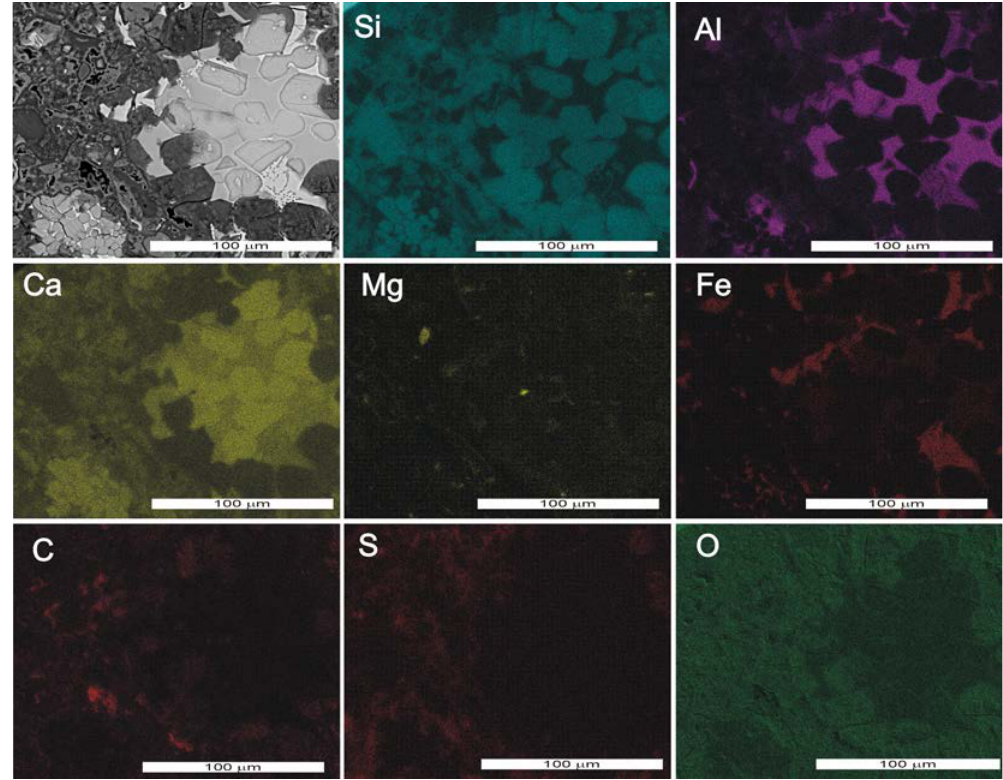
Figure 9. SEM elemental maps and backscattered (BSE) electron image showing the qualitative chemical composition of the cement mortar with residual cement grains for sample KD-M-3.